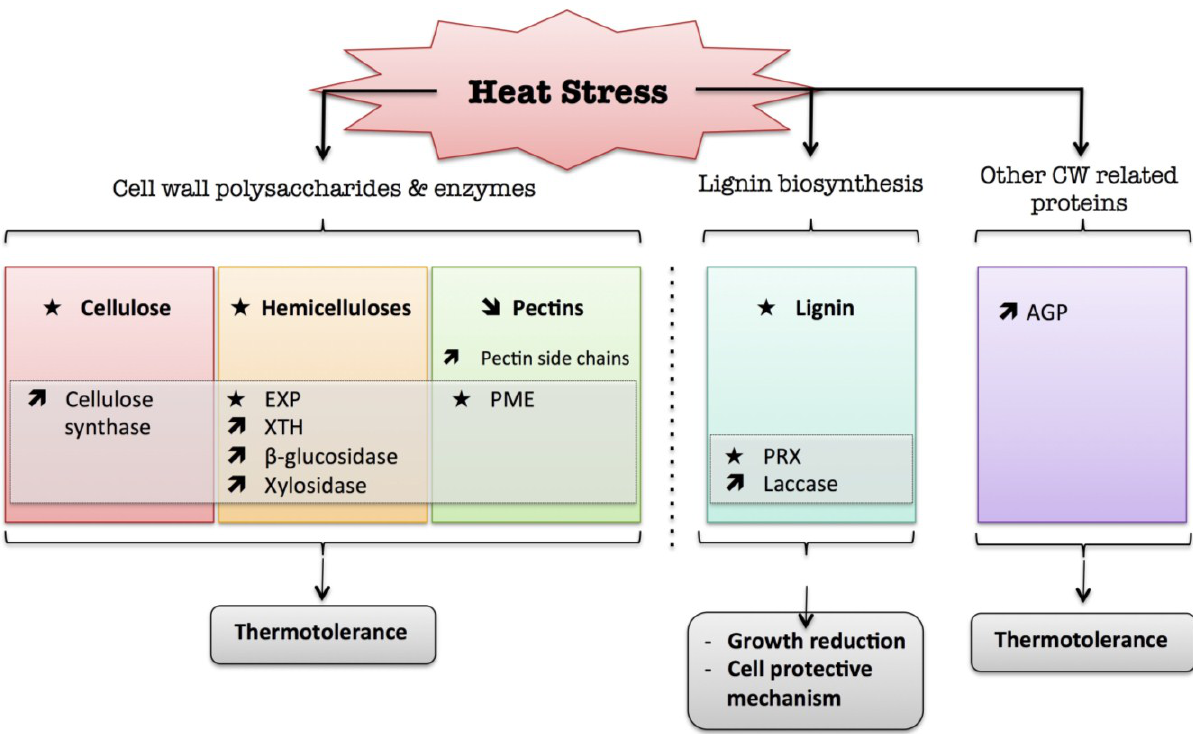
Figure 3. Diagram summarizing the plant cell wall response to heat. The schematic presentation is deduced from the results of different studies reported in the review. Arrow (  ) means increased abundance and arrow (  ) means decreased abundance of the molecules. Star (  ) means contrasting data on the gene/protein or the molecule studied according to the literature cited in the review. Cell wall (CW); xyloglucan endo-β-transglucosylases/hydrolases (XET/XTH); expansin (EXP); pectin methylesterase (PME); cell wall peroxidases (PRX); arabinogalactan protein (AGP). 5.